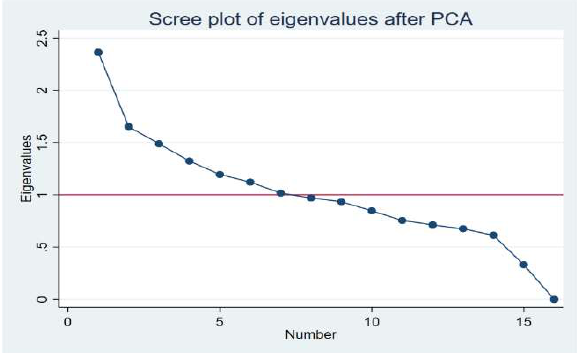
Figure 2. Scree plot of eigenvalues after Principal Components Method (PCA).